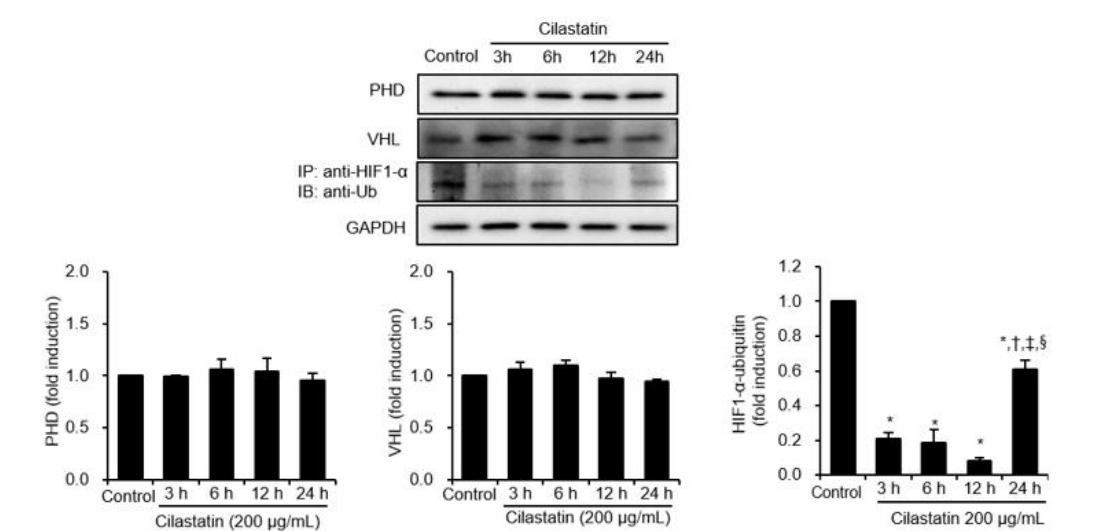
Figure 3. Cilastatin preconditioning upregulated HIF-1 α expression via the inhibition of ubiquitination in HK-2 cells. Semiquantitative immunoblotting showed that cilastatin pretreatment did not affect the levels of VHL and PHD expressions. Immunoprecipitation showed that HIF-1 α / ubiquitin complex formation was significantly suppressed in cilastatin-treated HK-2 cells compared to control in a time-dependent manner, but it was significantly increased at 24 h after cilastatin pretreatment. The data are presented as means ± SEM. * p < 0.05 vs. control, † , ‡ ,§ p < 0.05 vs. 3 h, 6 h, and 12 h after cilastatin treatment.